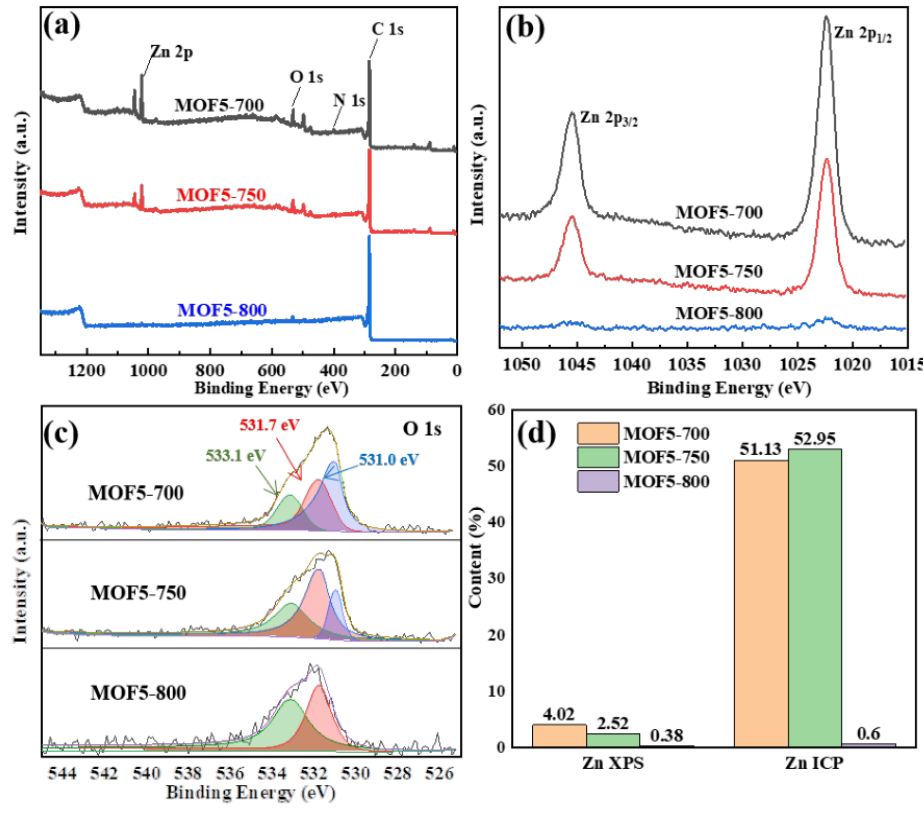
Figure 14. XPS diffraction spectra of MOF5-700, MOF5-750, MOF5-800: full spectrum ( a ), Zn 2p ( b ), O 1s ( c ), Zn content ( d ).